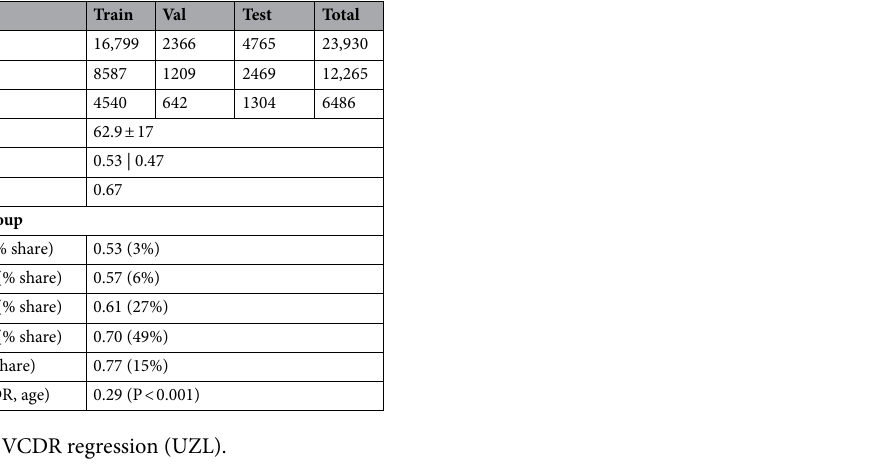
Table 1 data set characteristics for vertical cup-to-disc (VCDR) regression. The upper part gives train, valida- tion, and test splits on image, eye, and patient level. Data split was done randomly on patient level, assuring all images from the same patient to be in the same subset. The image data set consists of both glaucomatous and healthy eyes. The lower part of the table contains demographic information such as age (expressed in years) and sex (F = female, M = male), which are balanced across train, validation and test subsets. The correlation between VCDR and age is 0.29. Vertical cup‑to‑disc ratio (VCDR) regression. A total of 23,930 color fundus images (12,265 eyes, 6486 individuals) were included. The UZL patient set is predominantly Caucasian, has a mean age of 63 years, and consists of a balanced sex distribution, with 53% women. The mean VCDR label is 0.67. The largest age group